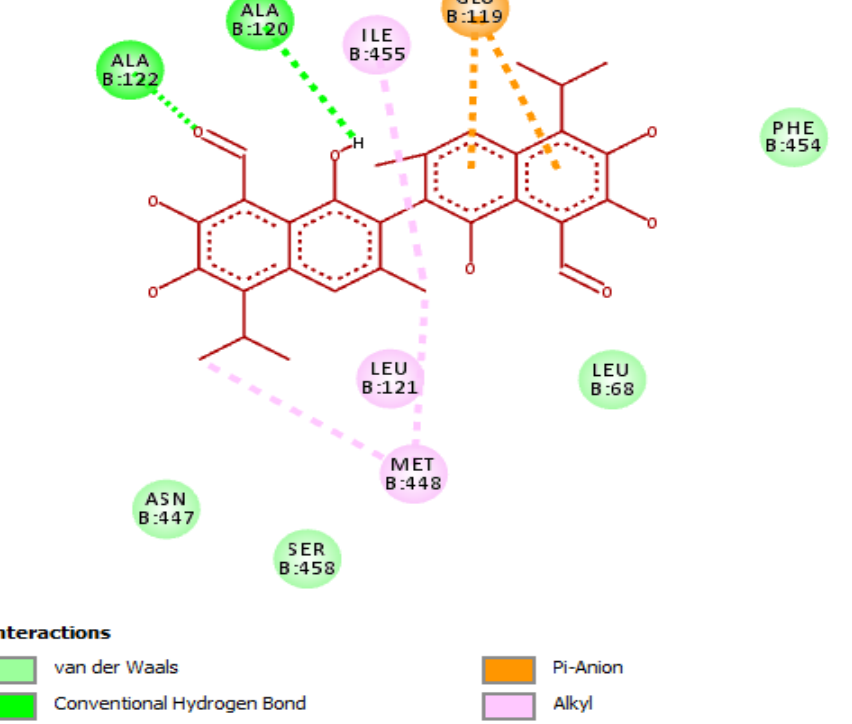
Figure 3. Molecular docking analysis (in a two-dimensional model) indicates the binding mode and the molecular interaction of gossypol with the Helicobacter pylori urease (HPU) active site. As shown, numerous crucial interactions between the functional groups of gossypol and amino acid residues of the active site of HPU are formed.